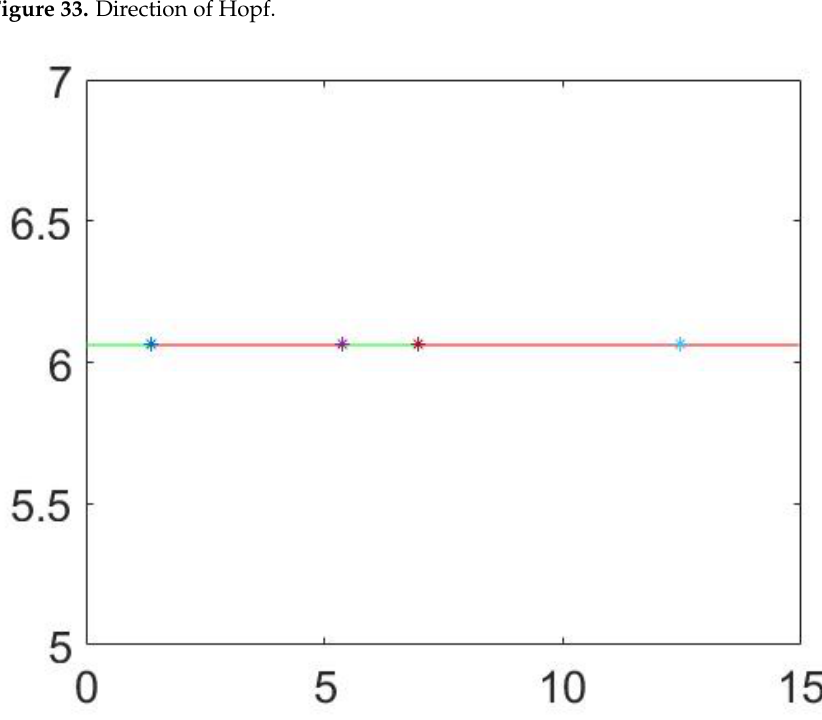
Figure 33. Direction of Hopf.